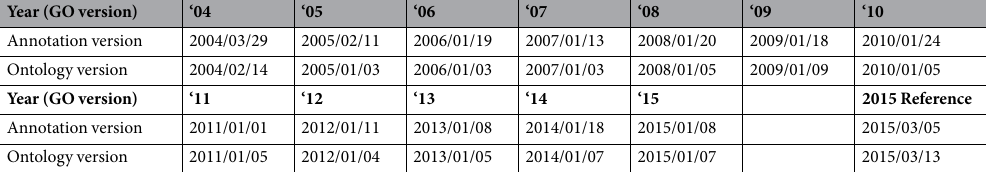
Table 1. GO annotation and ontology versions used in this